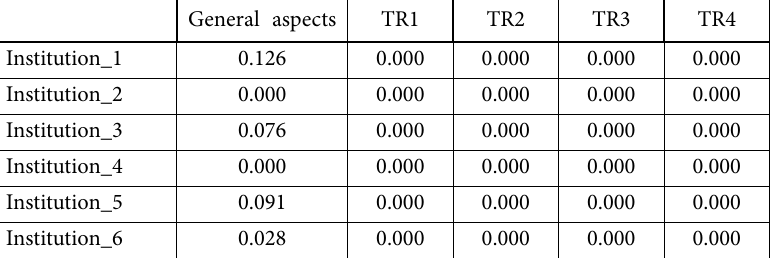
Table 7. Consistency ratio General